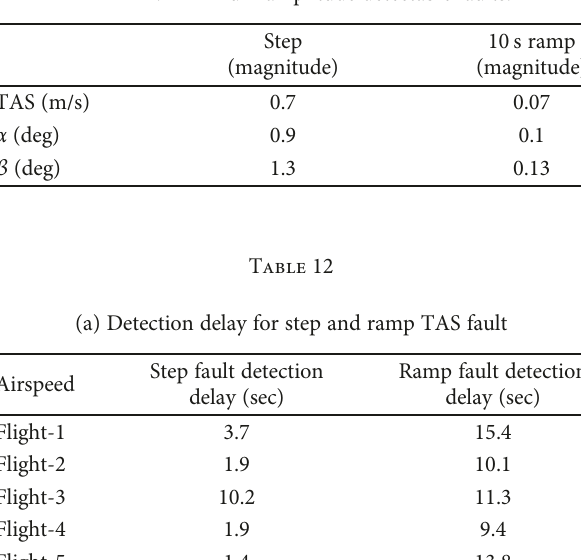
Table 11: Minimum amplitude detectable faults.